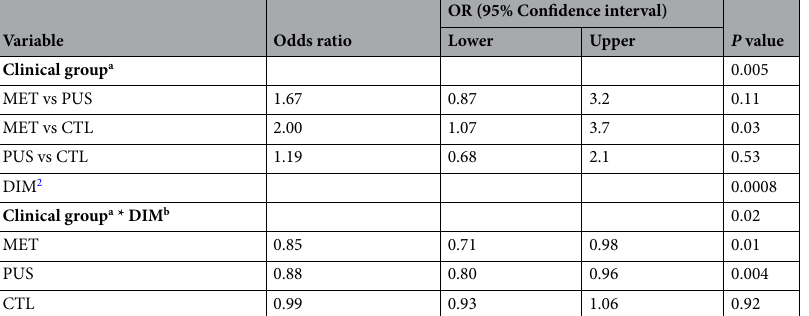
Table 2. Summary of the logistic regression model evaluating the effect of the clinical presentation groups (MET, PUS, or CTL) and the days in milk (DIM) on the odds ratio of isolation of E. coli from intrauterine swabs collected from cows at 25 commercial dairy farms. a Clinical presentation group (MET, PUS, or CTL) of cows when intrauterine samples were collected. (MET) metritis discharge defined as a watery, red or brown colored, and fetid vaginal discharge; (PUS) purulent discharge defined as a non-fetid purulent or mucopurulent vaginal discharge; and (CTL) control, healthy discharge defined as cows with either no vaginal discharge, clear mucus, or clear lochia. b Days in Milk at sampling time.